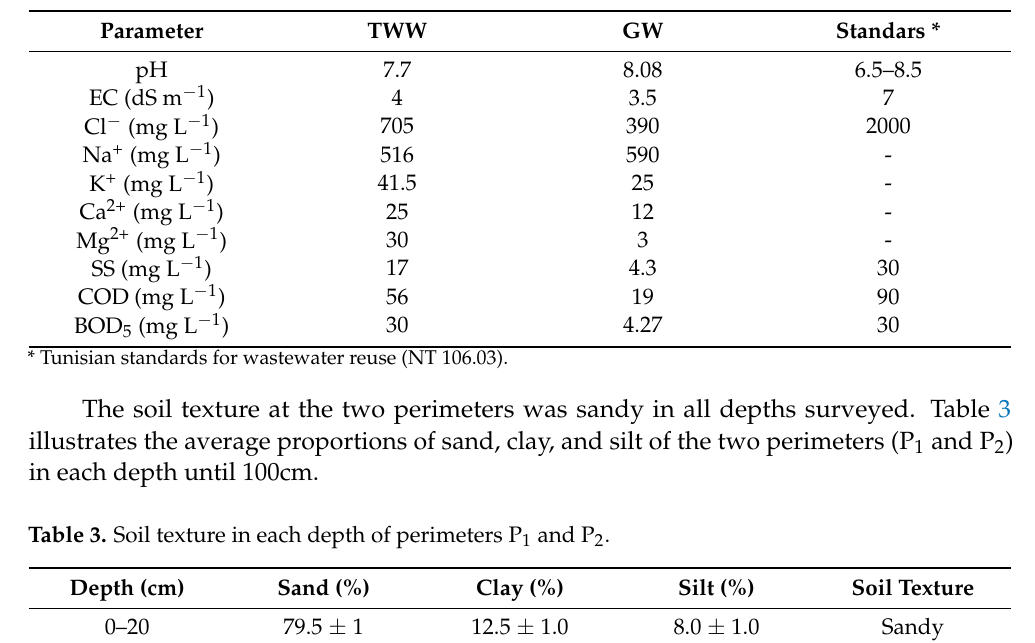
Table 2. Mean values of chemical properties of treated wastewater (TWW) generated by the wastew- ater treatment plant of Nabeul and groundwater (GW) from 2016 to2020 (RDAC Nabeul 2020). Parameter TWW GW Standars * pH